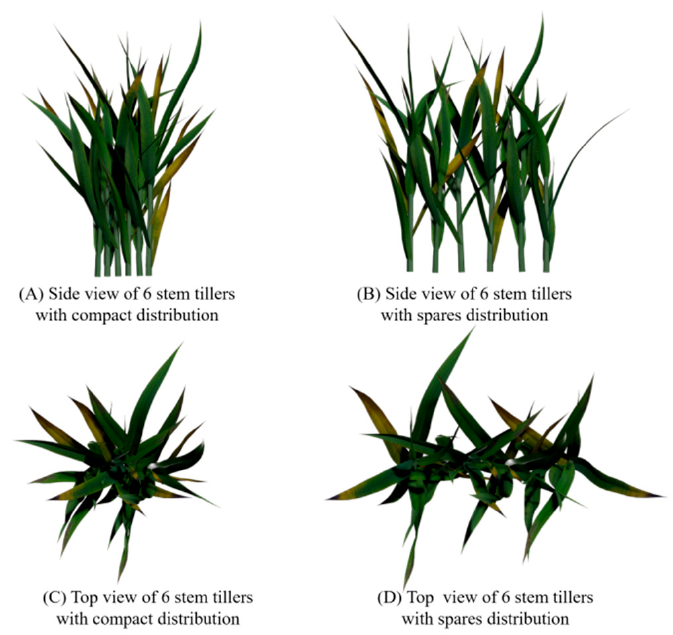
Figure 6. Photographs of tillering status of compact ( A , C ) and sparse ( B , D ) winter wheat.